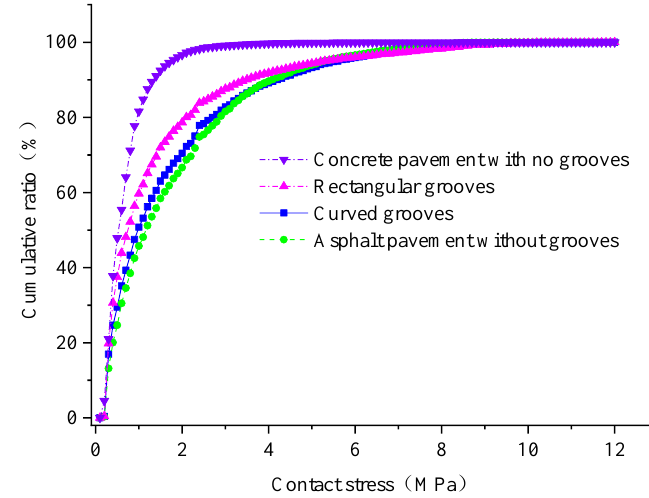
Figure 5. Contact stress distribution on different pavements.